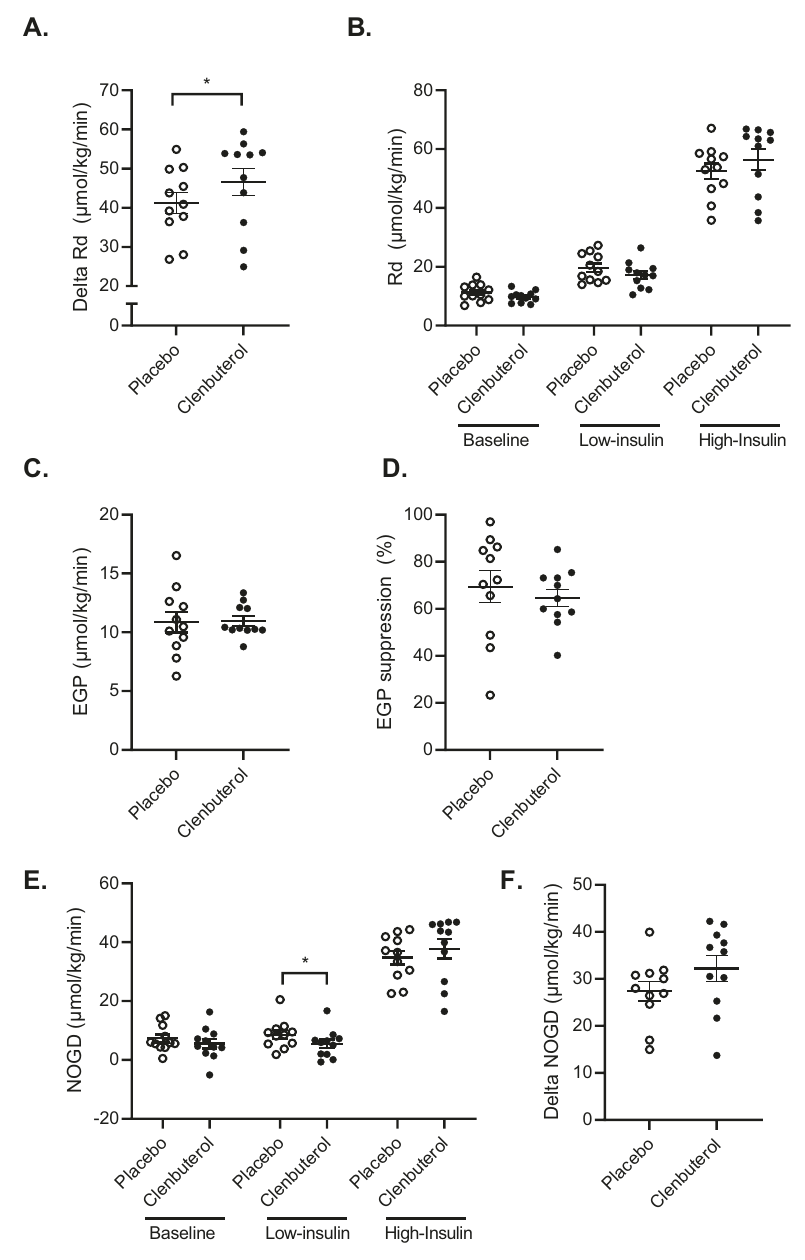
Fig. 2 | Clenbuterol treatment enhances peripheral insulin-stimulated glucose disposal. A Rate of glucose disposal (Rd) during the high-insulin phase corrected for baseline ( µ mol/kg/min) ( p =0.032). B Rate of glucose disposal during the hyperinsulinemic-euglycemic clamp at baseline, low- and high-insulin phases ( µ mol/kg/min). C Baseline endogenous glucose production (EGP) ( µ mol/kg/min). D Endogenousglucoseproductionsuppressionduringthelow-insulinphaseofthe hyperinsulinemic-euglycemicclamp (%). E Non-oxidative glucose disposal (NOGD)